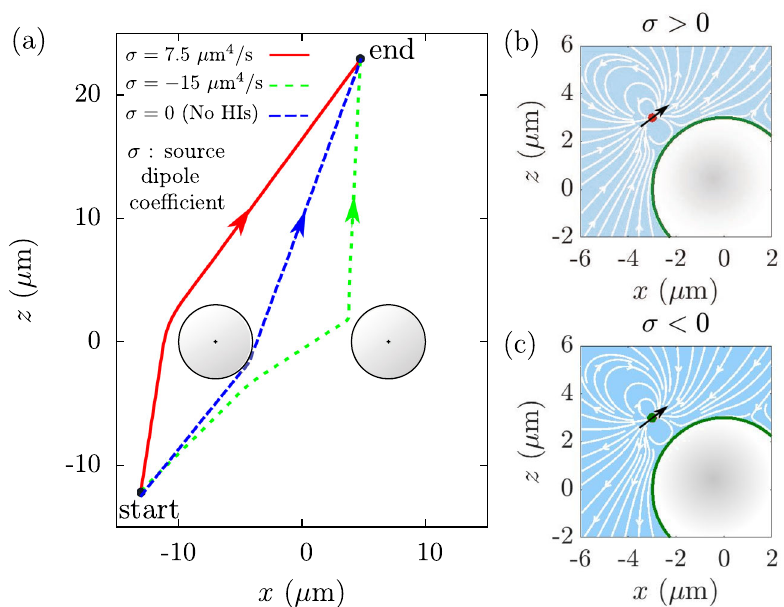
Fig. 1 Optimal microswimmer navigation near spherical obstacles. a Curves represent optimal trajectories for microswimmers (red and green) and for a dry active particle (blue), i.e., in the absence of hydrodynamic interactions (HIs) with obstacles (shown in gray). The swimmers are micron sized and the swimming trajectories are assumed to take place in the plane passing through the centers of the spherical obstacles. Here, σ is the source dipole coef fi cient and x , z are spatial coordinates. Panels b , c show the fl ow fi eld streamlines induced by a source dipole at position r = ( − 3, 3) μ m in the presence of a spherical obstacle with radius R = 3 μ m. Black arrows indicate the orientation of the swimmers. The fl uid-mediated hydrodynamic interactions with the spherical boundary induce a deceleration of the swimming agent for σ > 0 leading to larger speeds as the swimmer gets away from the obstacle. In contrast to that, hydrodynamic interactions cause an acceleration for σ < 0 yielding an increased speed near the